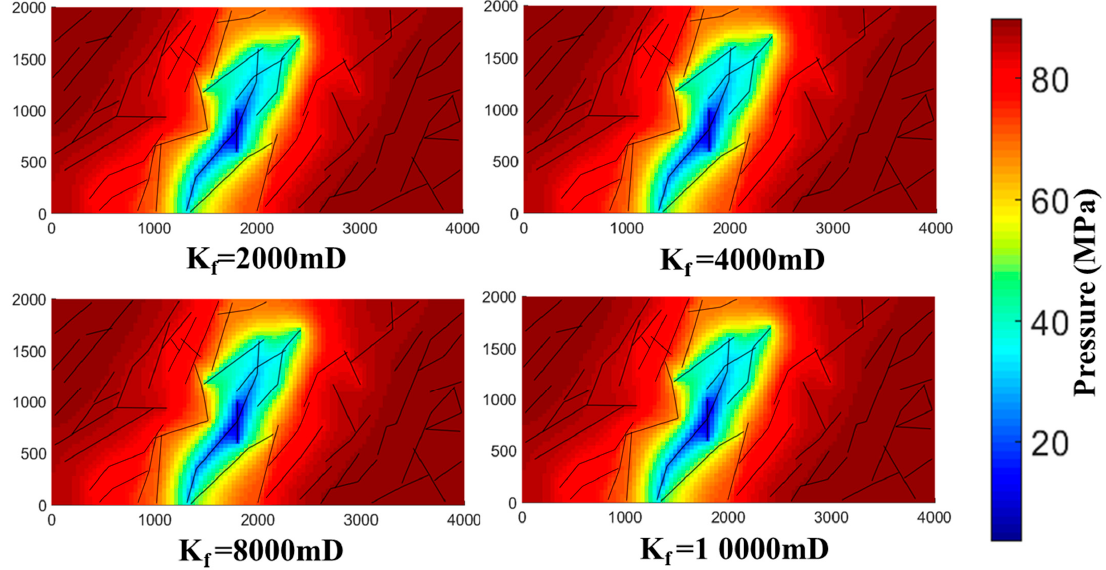
Figure 14. Schematic diagrams of the distribution of pressure-drop loopholes at the end of the pre- diction period for different fracture-permeability models.